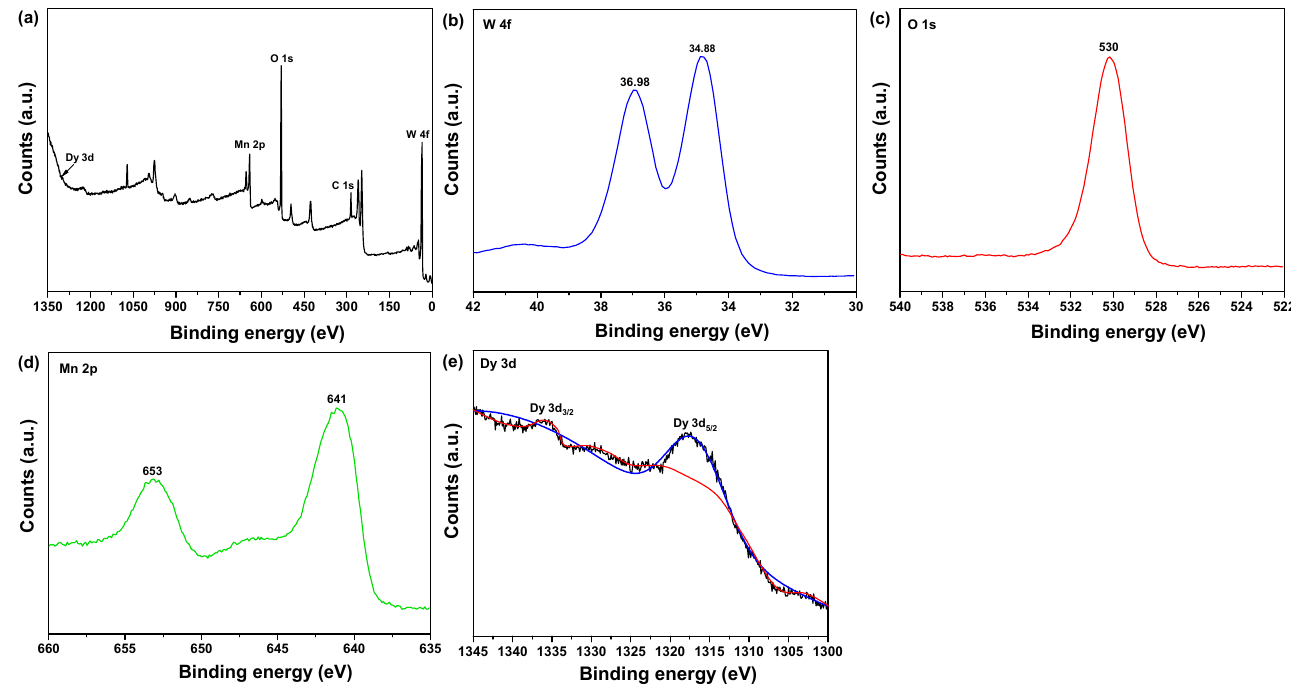
Figure 5. XPS data of MnWO 4 :Dy 3+ : ( a ) survey, ( b ) W 4f, ( c ) O 1s, ( d ) Mn 2p, and ( e ) Dy 3d.